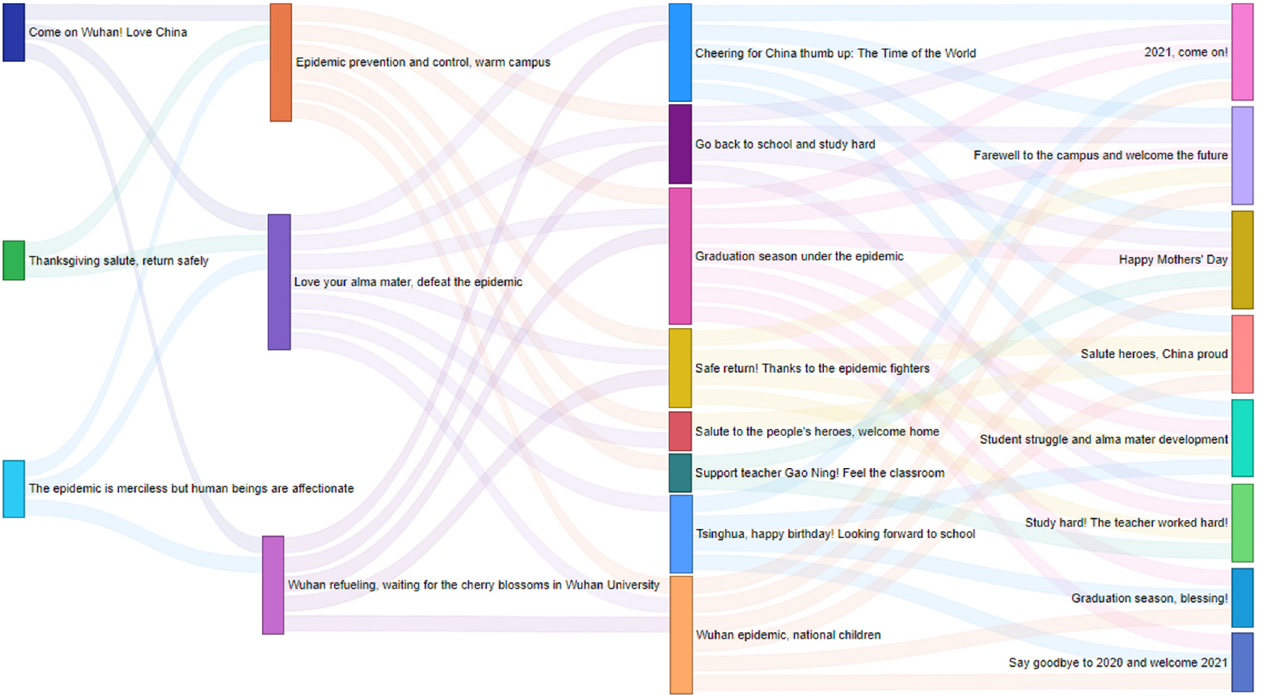
Figure 9. Topic content evolution map of positive comment.